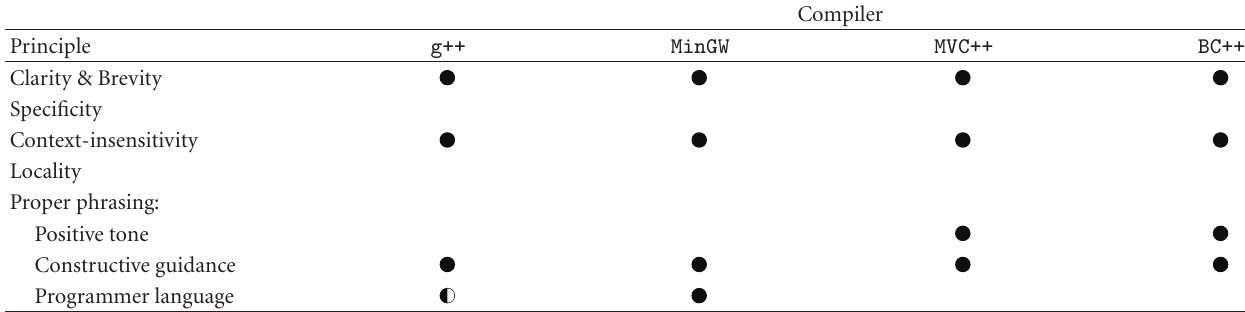
Table 8: Which principles are violated by which compilers for Error message